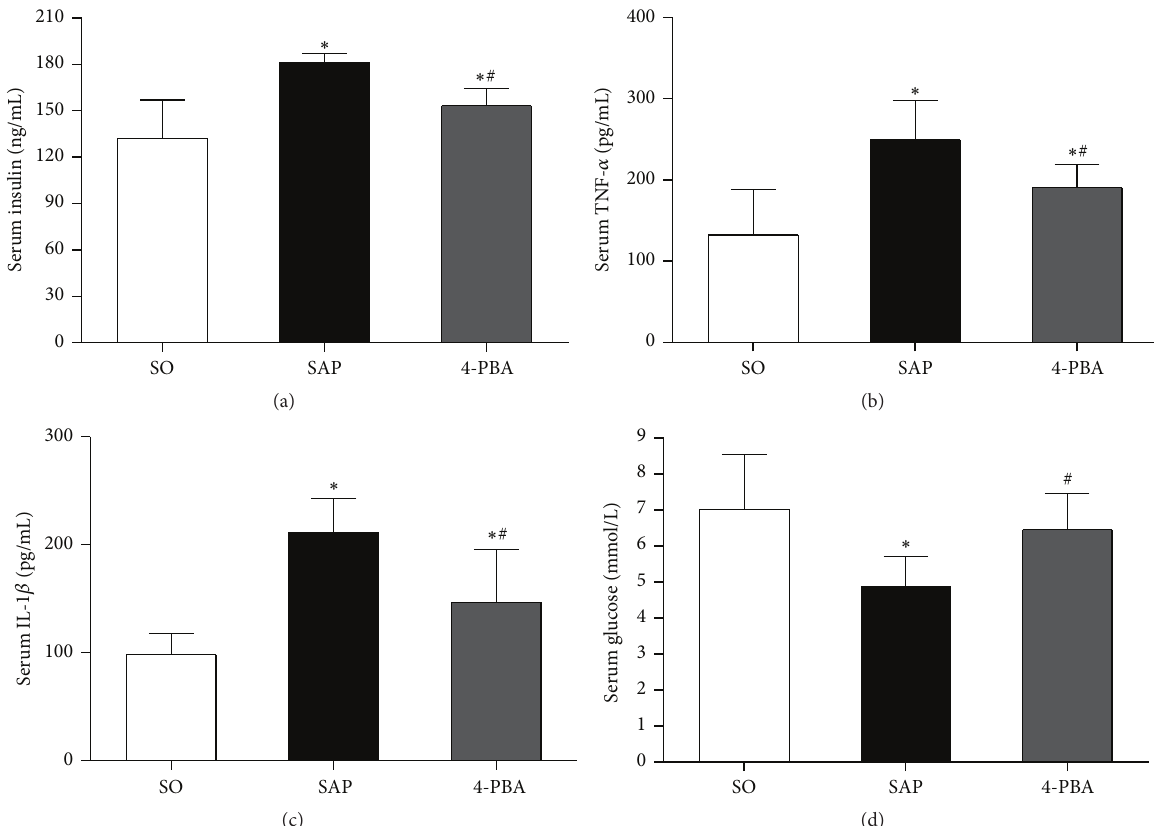
Figure 4: Effects of 4-phenylbutyric acid on insulin, inflammatory cytokine, and glucose production in serum. (a) Insulin; (b) TNF- 𝛼 ; (c) IL-1 𝛽 ; (d) glucose. Each value represents the mean ± standard deviation. ∗ 𝑃 < 0.05 versus SO group; # 𝑃 < 0.05 versus SAP